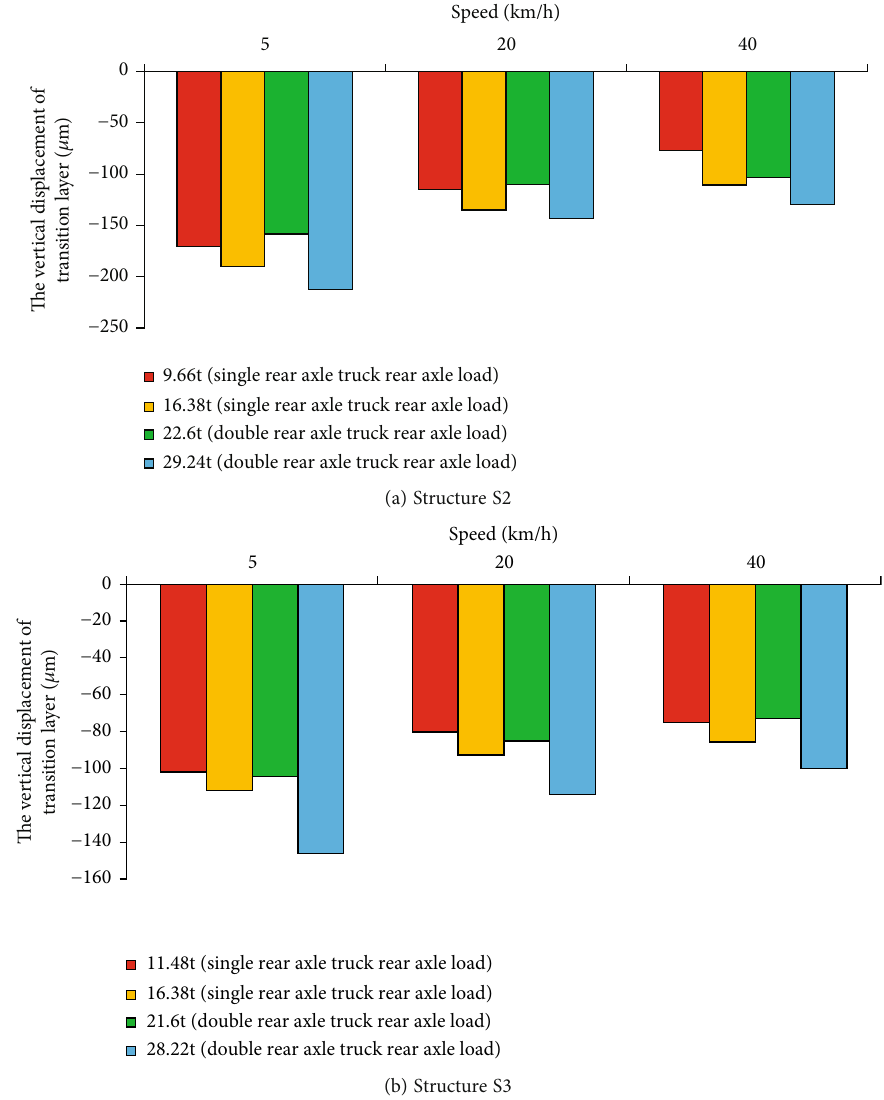
Figure 9: Relation between vertical displacement of transition layer and axle